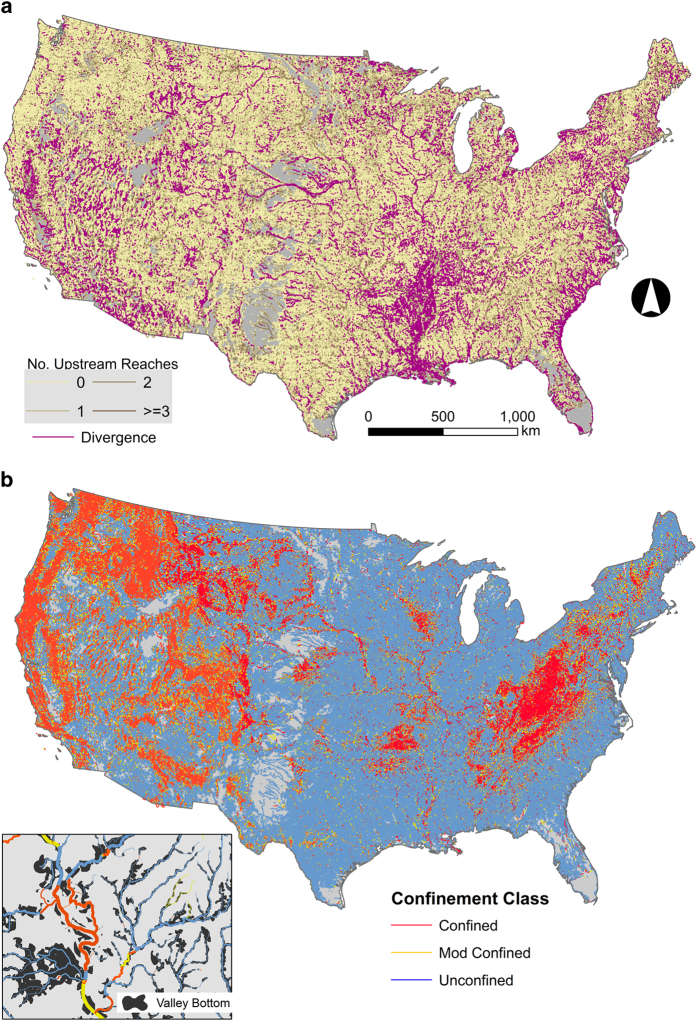
Network Bifurcation and valley confinement of stream reaches of the conterminous US.(a) Information used to develop network bifurcation classes in streams included the number of upstream reaches contributing to each reach and divergences in channels. Mapping bifurcation classes was impractical as there are 348 different types. (b) Valley confinement classes mapped to stream reaches. Inset provides example of valley bottoms underlaying streams of varying widths.